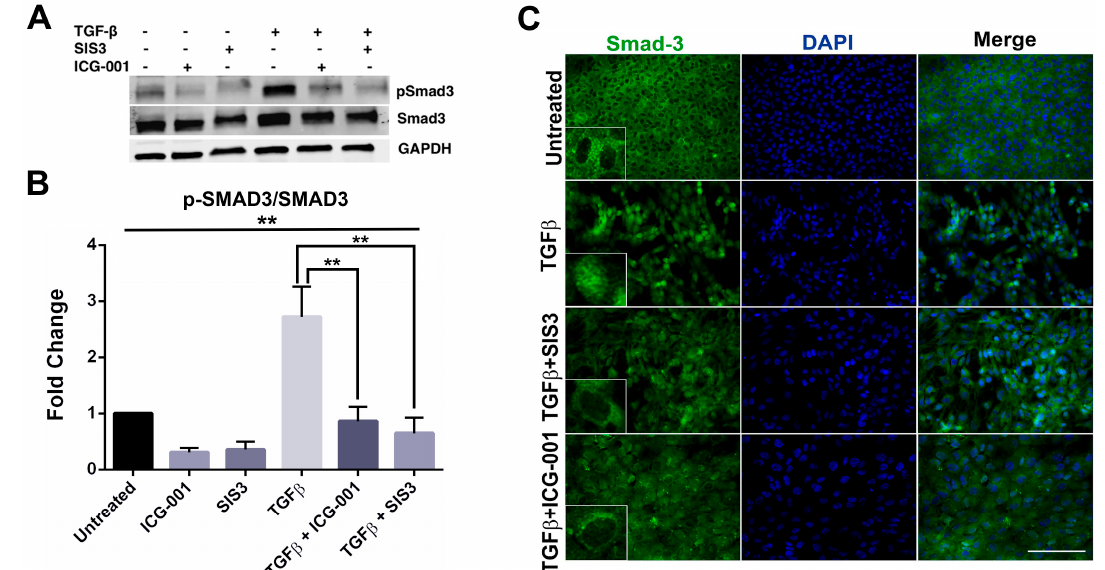
Figure 3. Inhibition of β -catenin signaling blocks activation and delocalization of Smad3. ( A ) Western blot analyses was performed using protein isolated from rat lens explants incubated with TGF- β in the presence or absence of SIS3 or ICG-001 ( n = 3 where n ≥ 6 explants per treatment) and probed for Smad3 and pSmad3, with GAPDH used as a loading control. ( B ) Graph showing the statistical analysis of western blot band densities for pSmad3 compared to Smad3 normalized with the loading control (GAPDH) with ± standard deviation (GAPDH) ( n = 3, p < 0.01) ( C ) Rat lens explants were treated with TGF- β alone (panel 2) and in the presence of SIS3 (panel 3) or ICG-001 (panel 4) for 48 h ( n = 3 where n ≥ 5 explants per treatment). The explants were then fixed and stained for Smad3 and mounted with DAPI to visualize nuclei. The images were acquired using 40× lens of Leica DM6 fluorescence microscope. Insets show inhibition of TGF- β -induced nuclear Smad3 in the presence of either SIS3 or ICG-001. Scale bars set to 100 µ m.